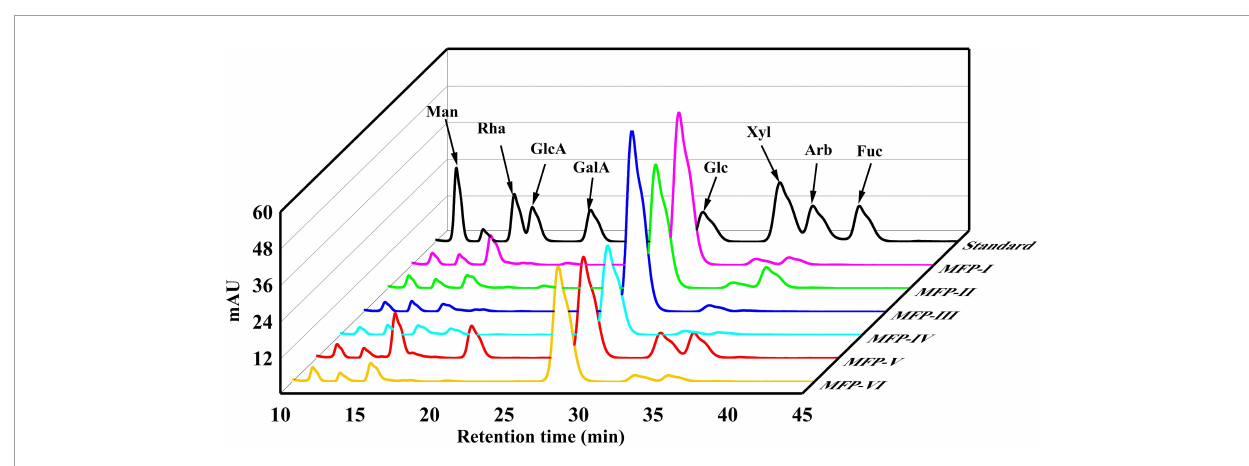
FIGURE3 HPLC diagram of monosaccharide standard and different components of mulberry